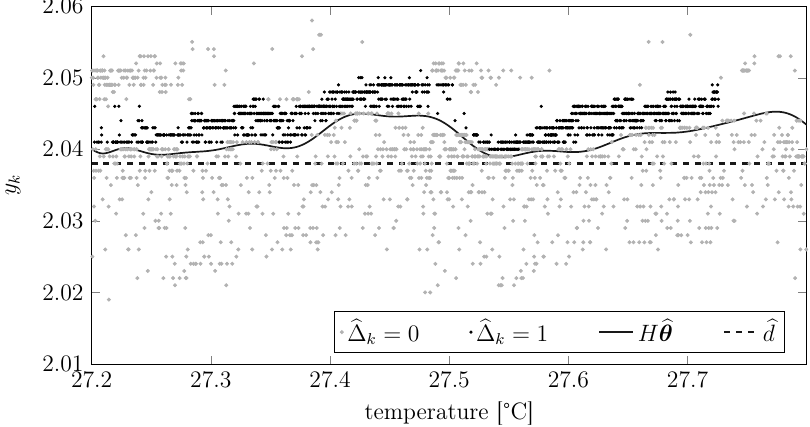
Figure 11. Application of the EM testing algorithm on real data, where the raw measurements are plotted versus the temperature of the device. The black dots are the raw measurements that have been associated with lasing Mode 1, while the gray dots are the measurements associated with lasing Mode 2. The solid line denotes the temperature-induced bias on the measured distance.